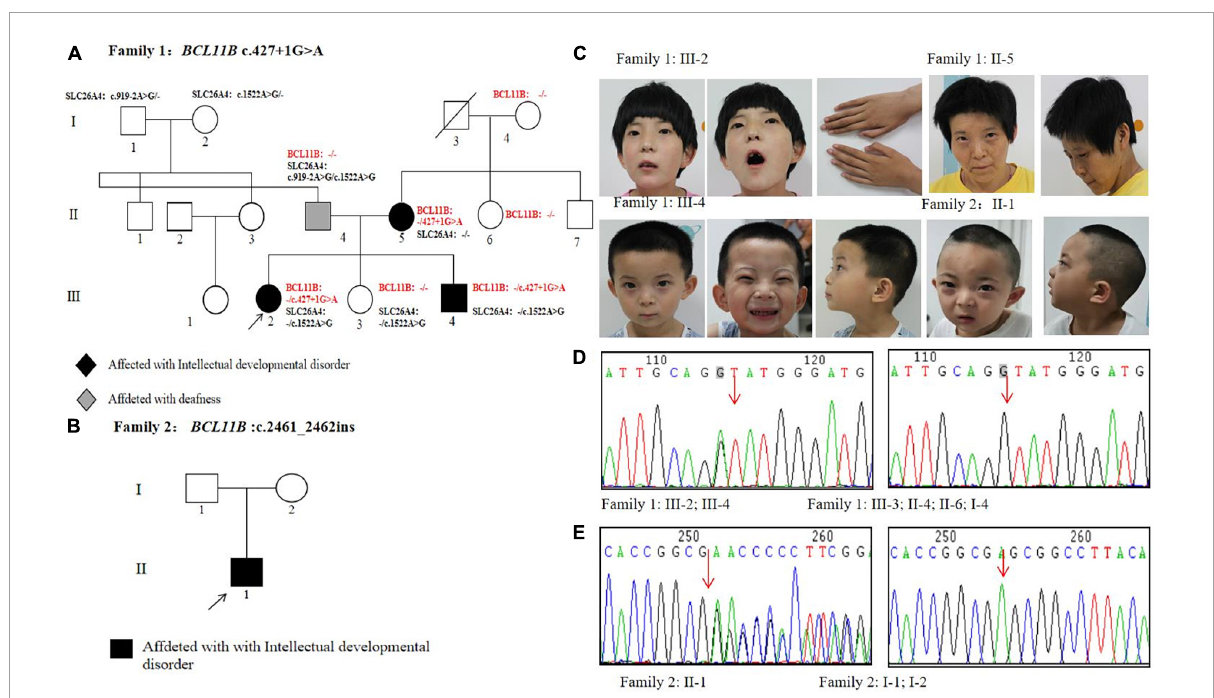
FIGURE1 Pedigrees and genetic analysis of two families. (A) The pedigree of Family 1 carrying a splice variant c.427 + 1G > A in BCL11B . (B) The pedigree of Family 2 carrying a frameshift variant c.2461_2462insGAGCCACACCGGCG in BCL11B . (C) Images of patients with BCL11B variants. (D) The sanger sequencing of the c.427 + 1G > A variant in Family 1 members. (E) The sanger sequencing of the c.2461_2462insGAGCCACACCGGCG variant in Family 2